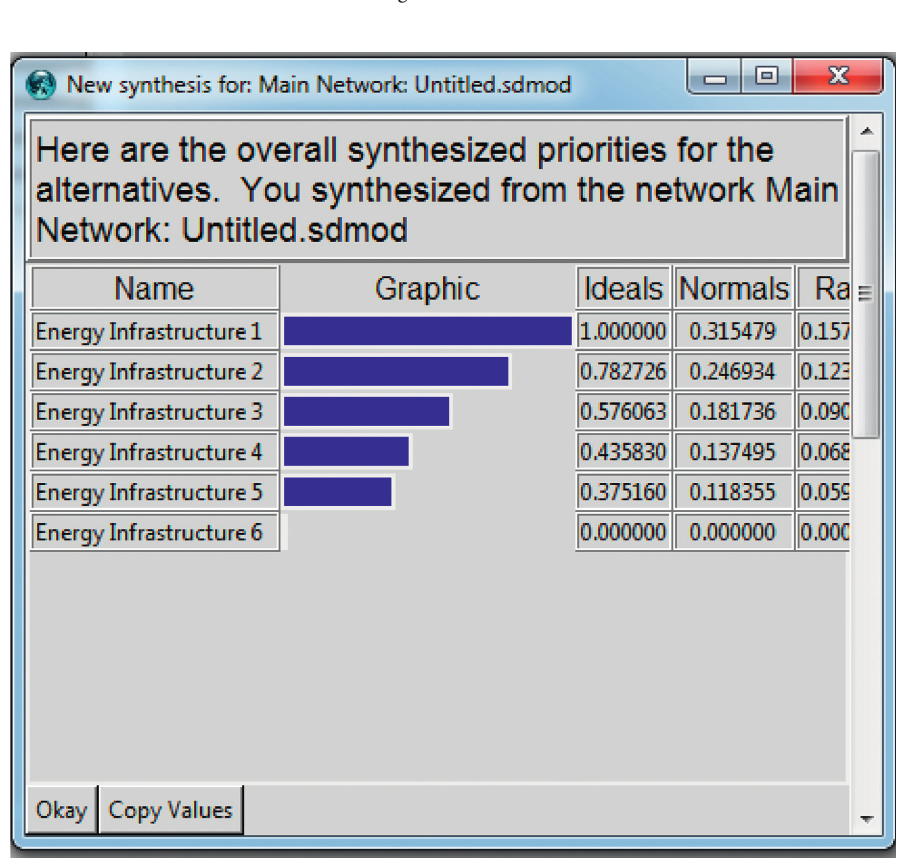
Figure 6: Overall synthesized priorities for the